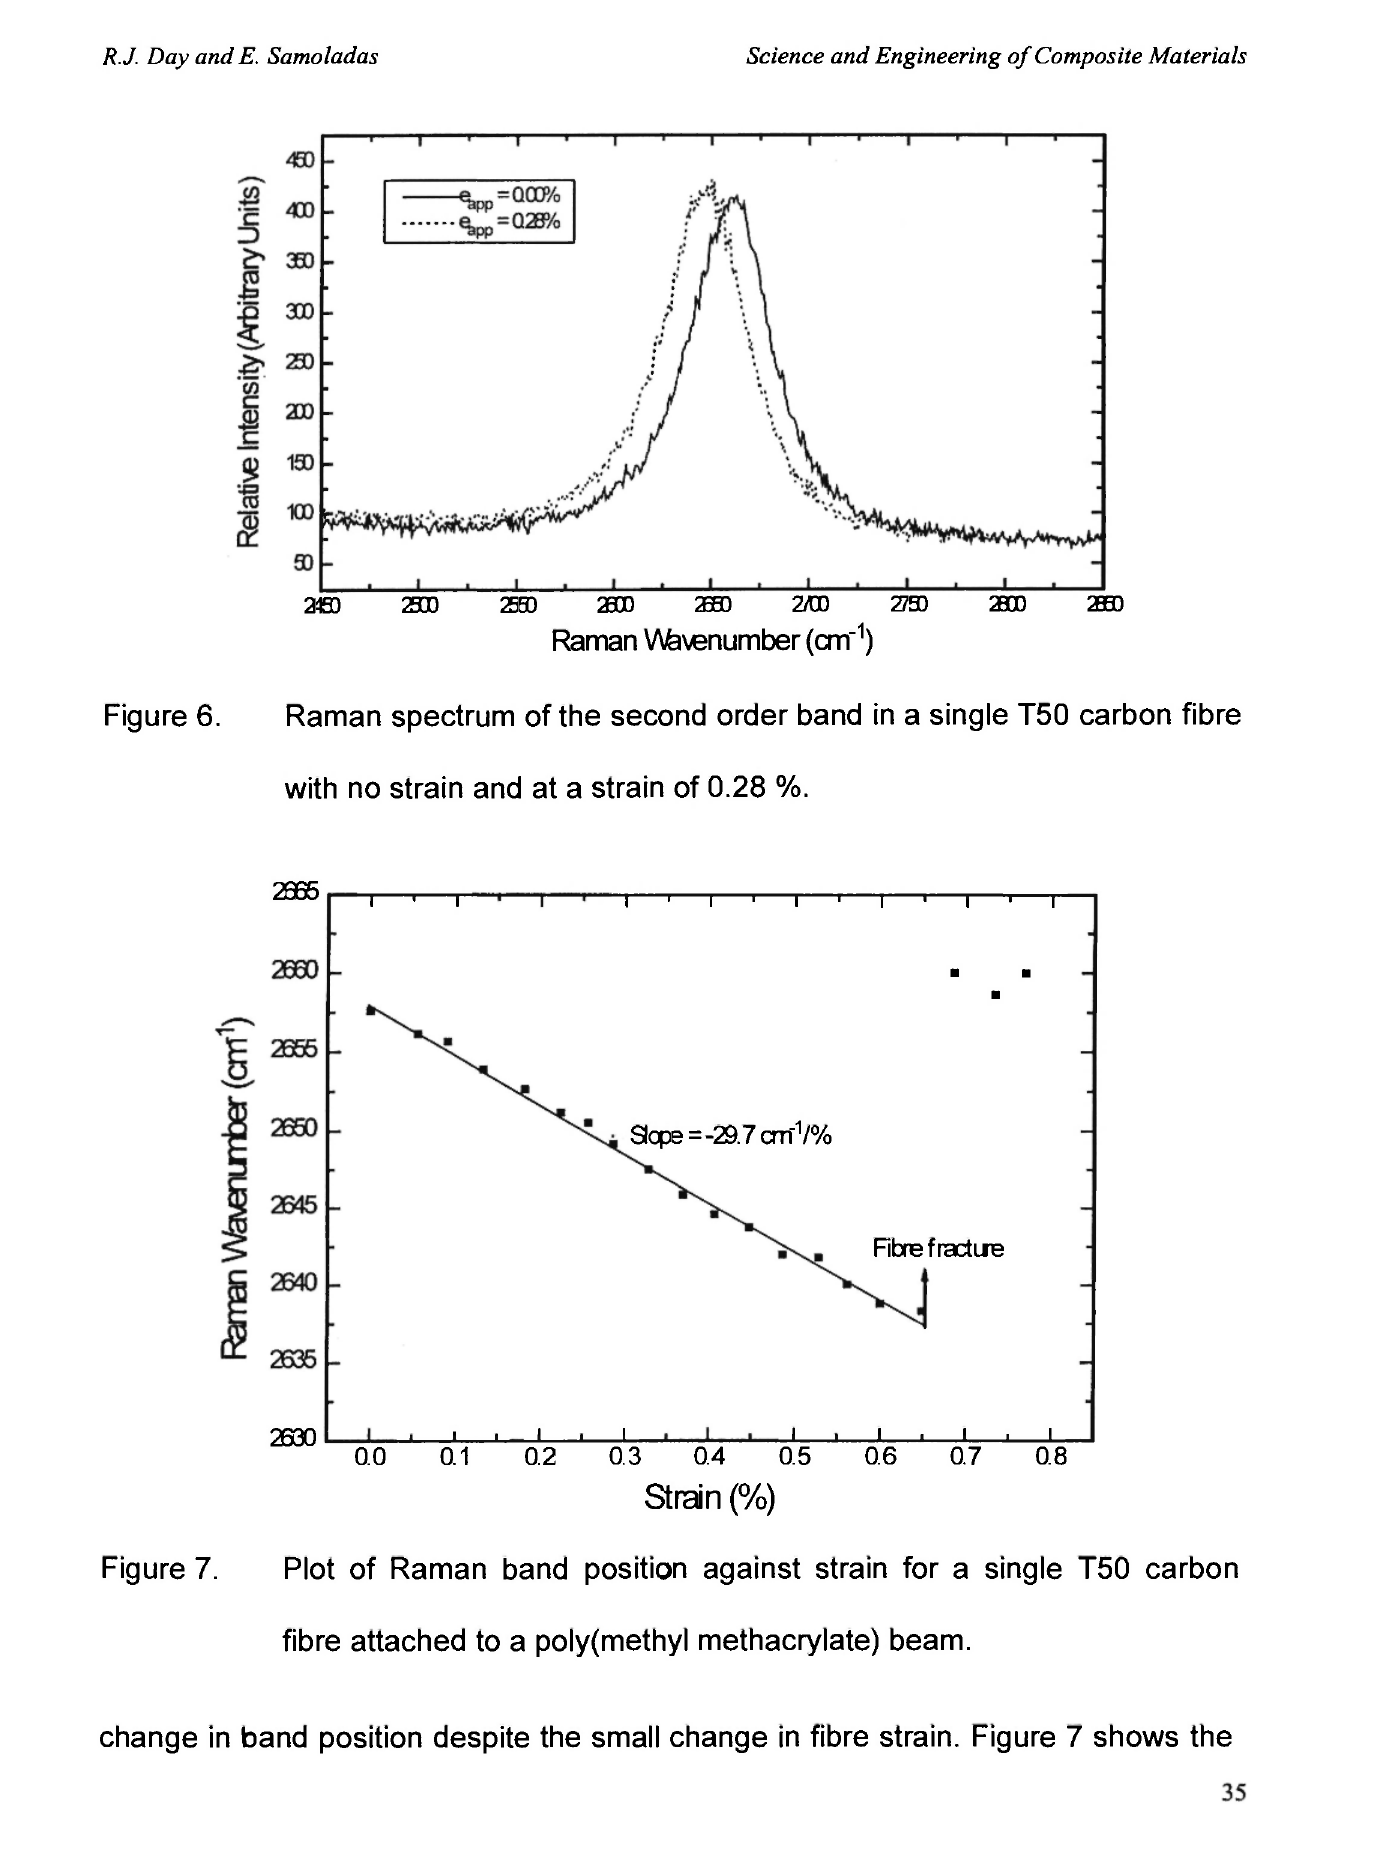
Figure 7. Plot of Raman band position against strain for a single T50 carbon fibre attached to a poly(methyl methacrylate)